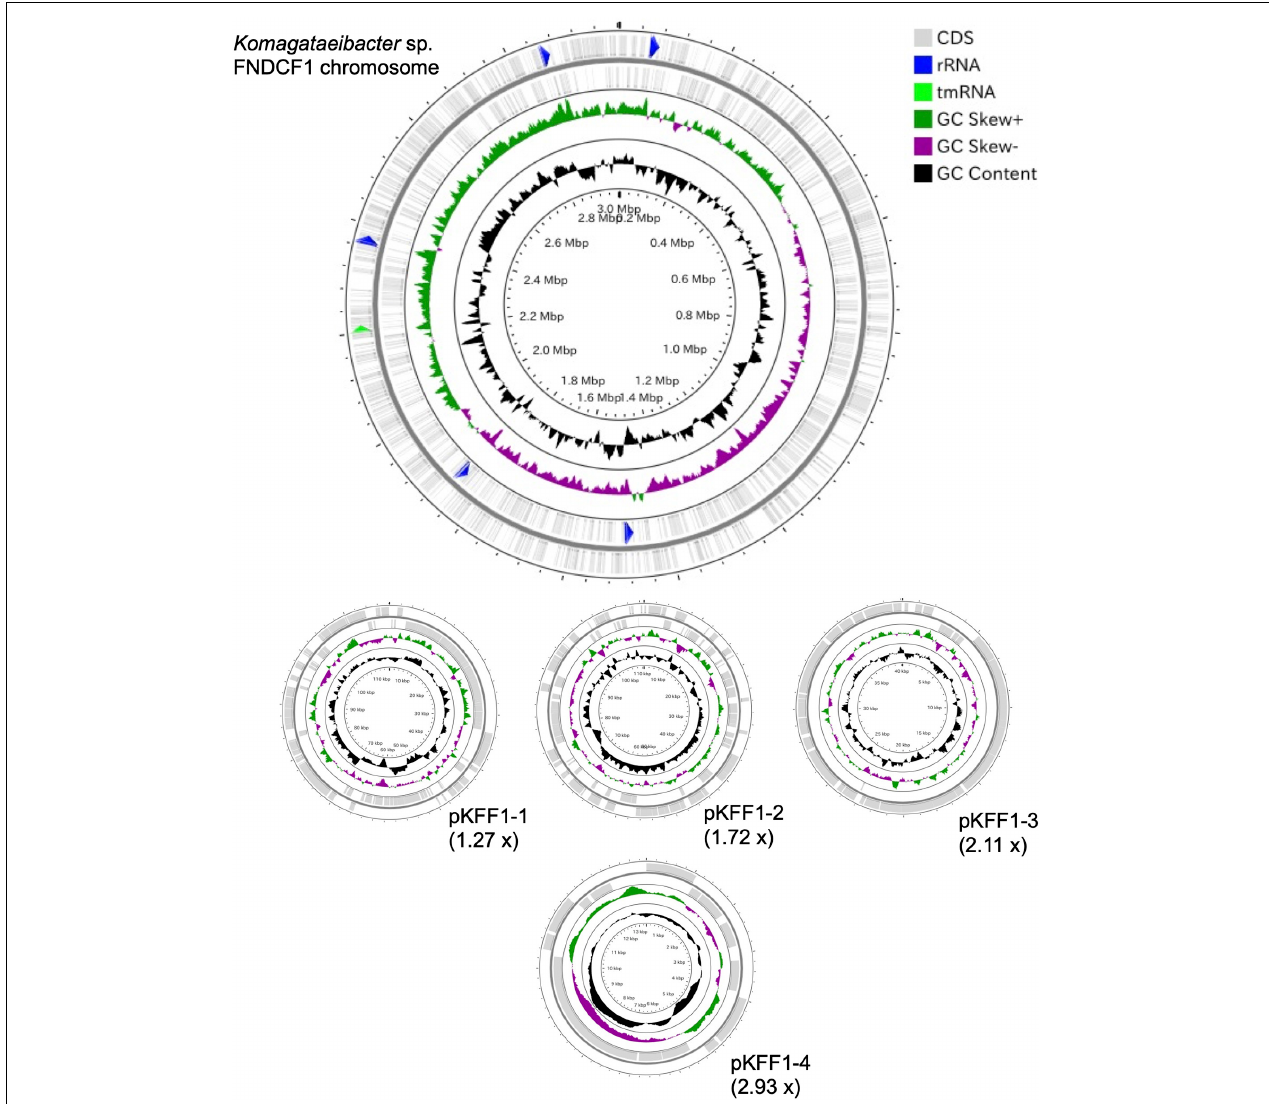
FIGURE 3 | Genome structure of the FNDCR1 strain. One circular chromosome and four putative plasmids (pKFF1-1, pKFF1-2, pKFF1-3, and pKFF1-4 pKFR1-7) are shown. The value given in parentheses represents the sequencing coverage of a plasmid relative to that of chromosome. Smaller contigs below 5,000 bp and non-circularized contigs are not shown in this